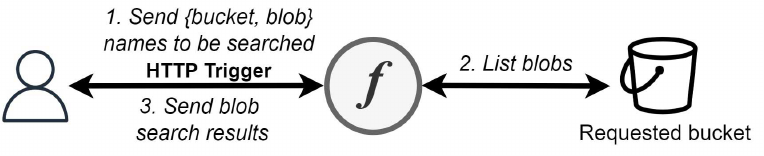
Figure 7. Use case 3— search blobs